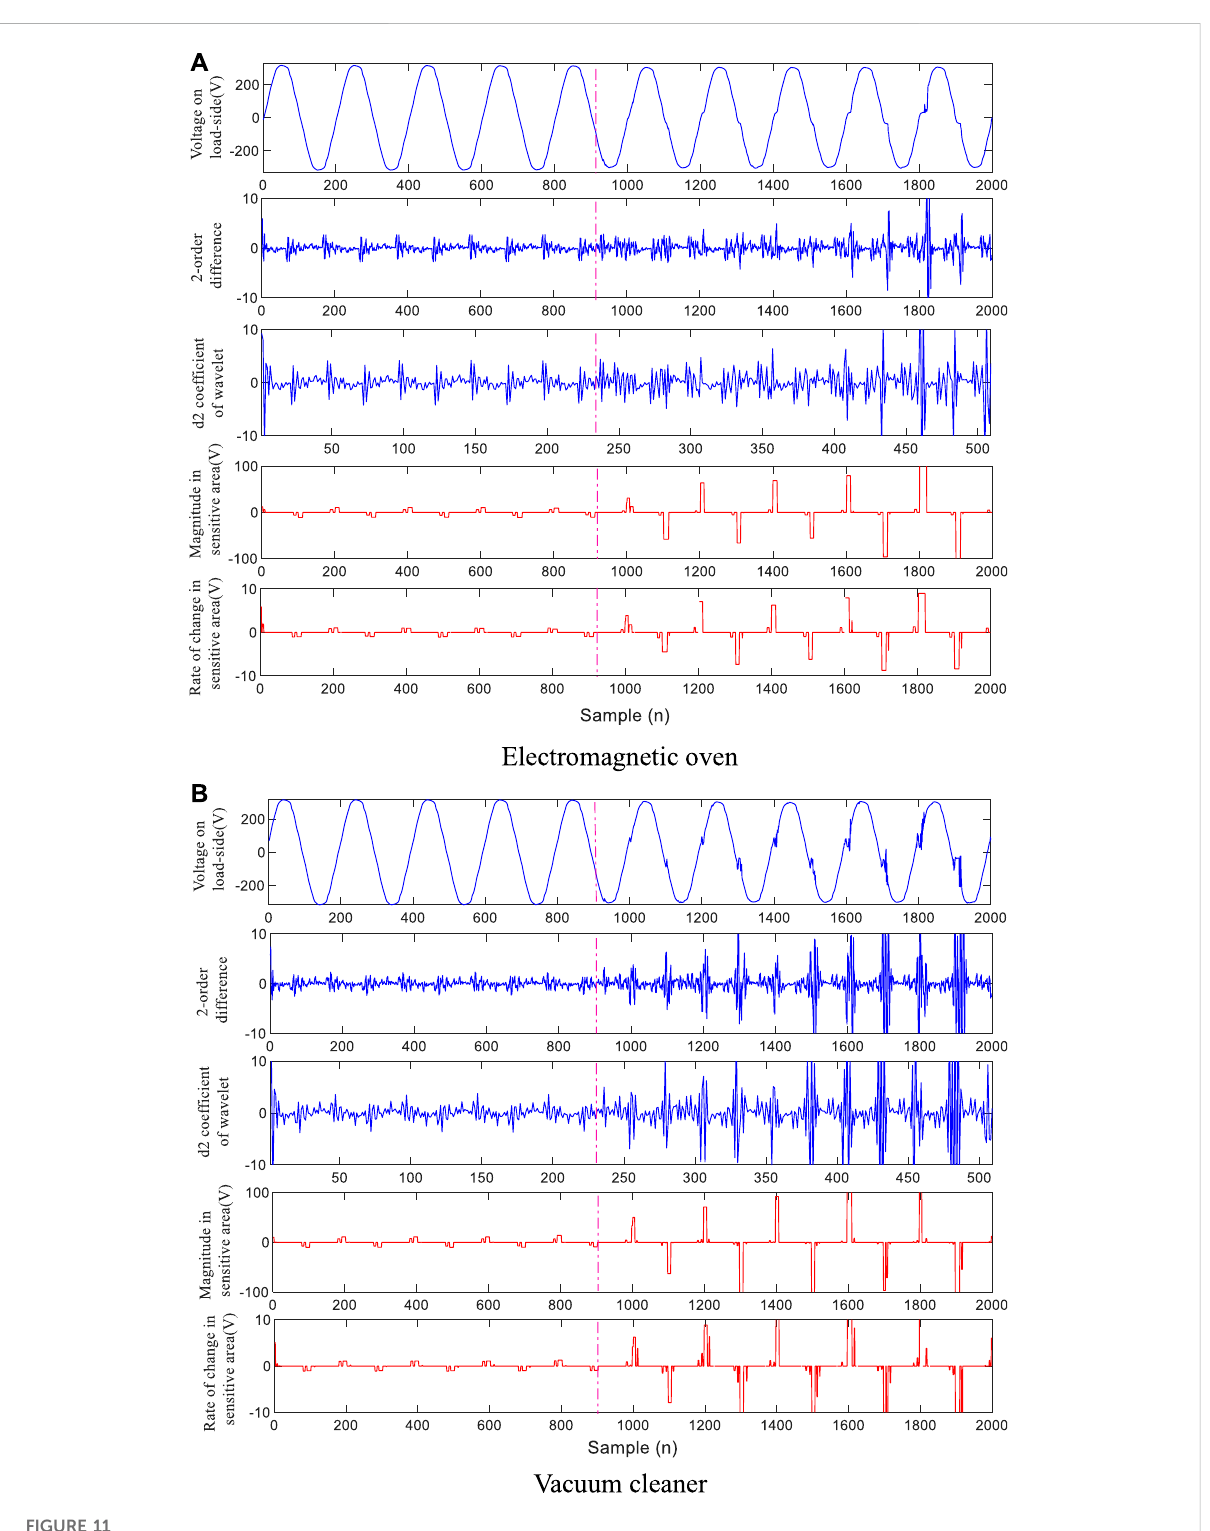
FIGURE 11 Comparison of identi fi cation effects of related methods (A) Electromagnetic oven (B) Vacuum